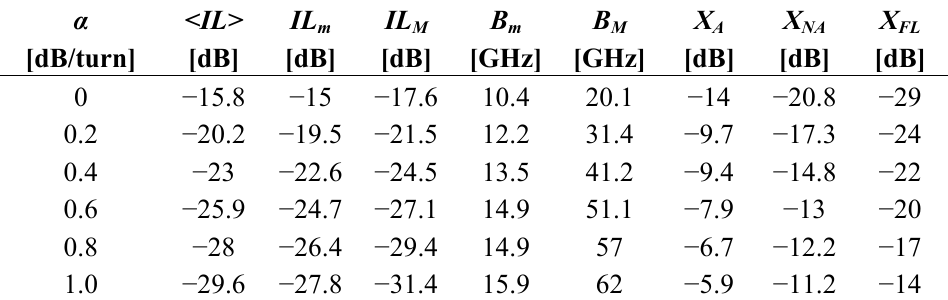
Table 2. Increasing loss/turn, 32@50